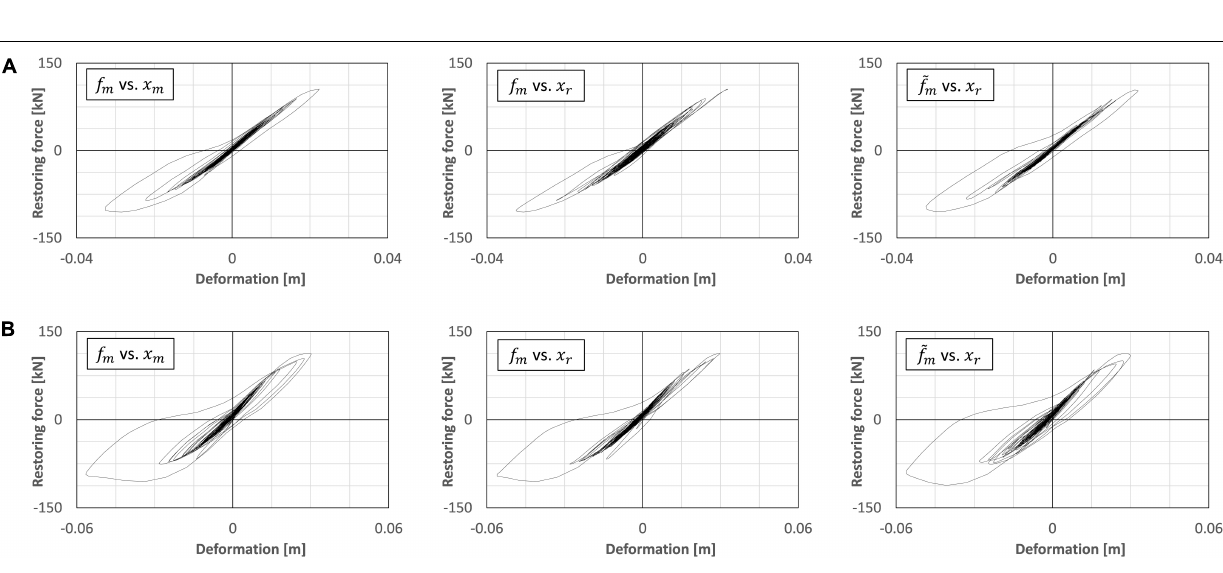
Frontiers in Built Environment |